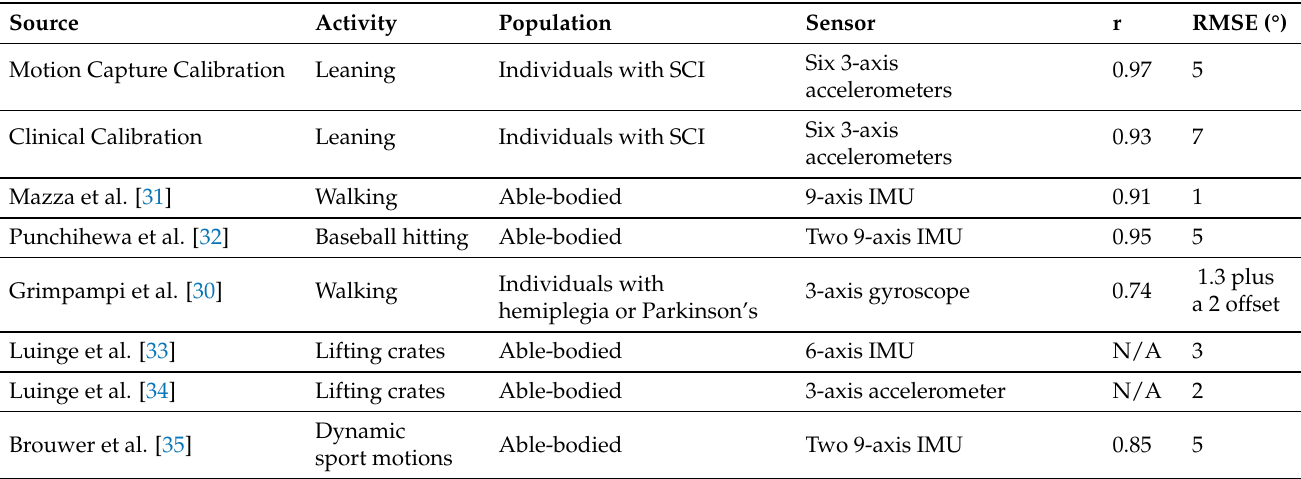
Table 4. Comparison of previous work with the results from our study (first two